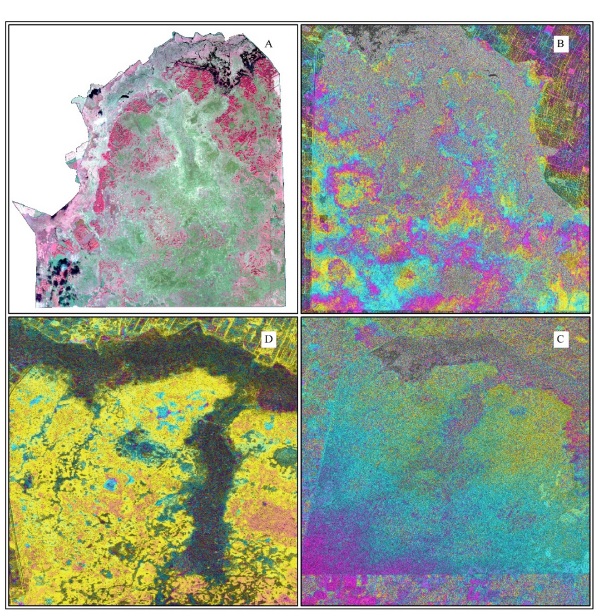
Figure 3 interferometric fringe after adaptive Goldstein filtering and phase flattening: A was the RGB image derived from wavelet fusion of GF-1 multispectral image and HH polarization Radarsat-2 backscattering intensity data; B was the interferometric fringe generated by TerraSAR images; C was interferometric fringe generated by Sentinel-1A images. D is the interferometric fringe produced by PALSAR